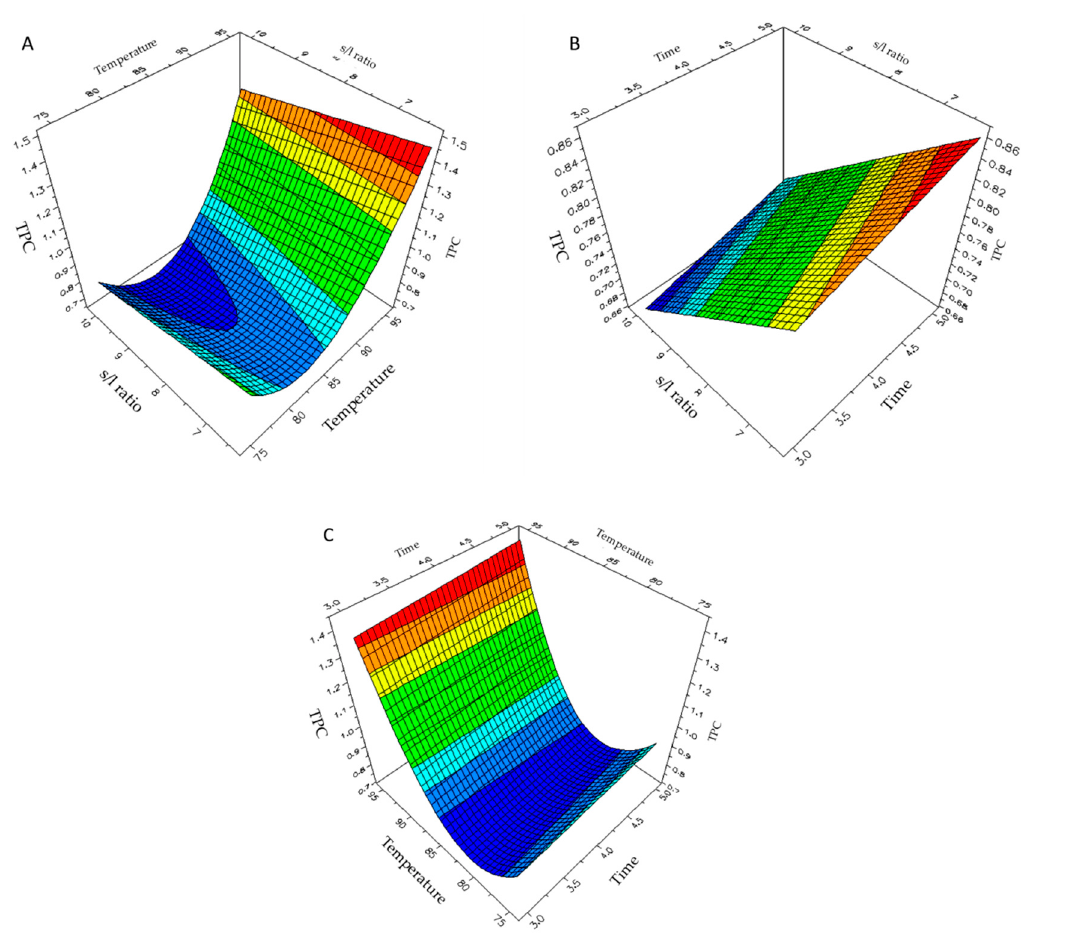
Figure 1. Response surface plots of the effect of ( A ) solid/liquid ratio and extraction temperature, ( B ) solid/liquid ratio and extraction time, ( C ) extraction temperature and time on polyphenol yield (TPC) obtained through MAE.